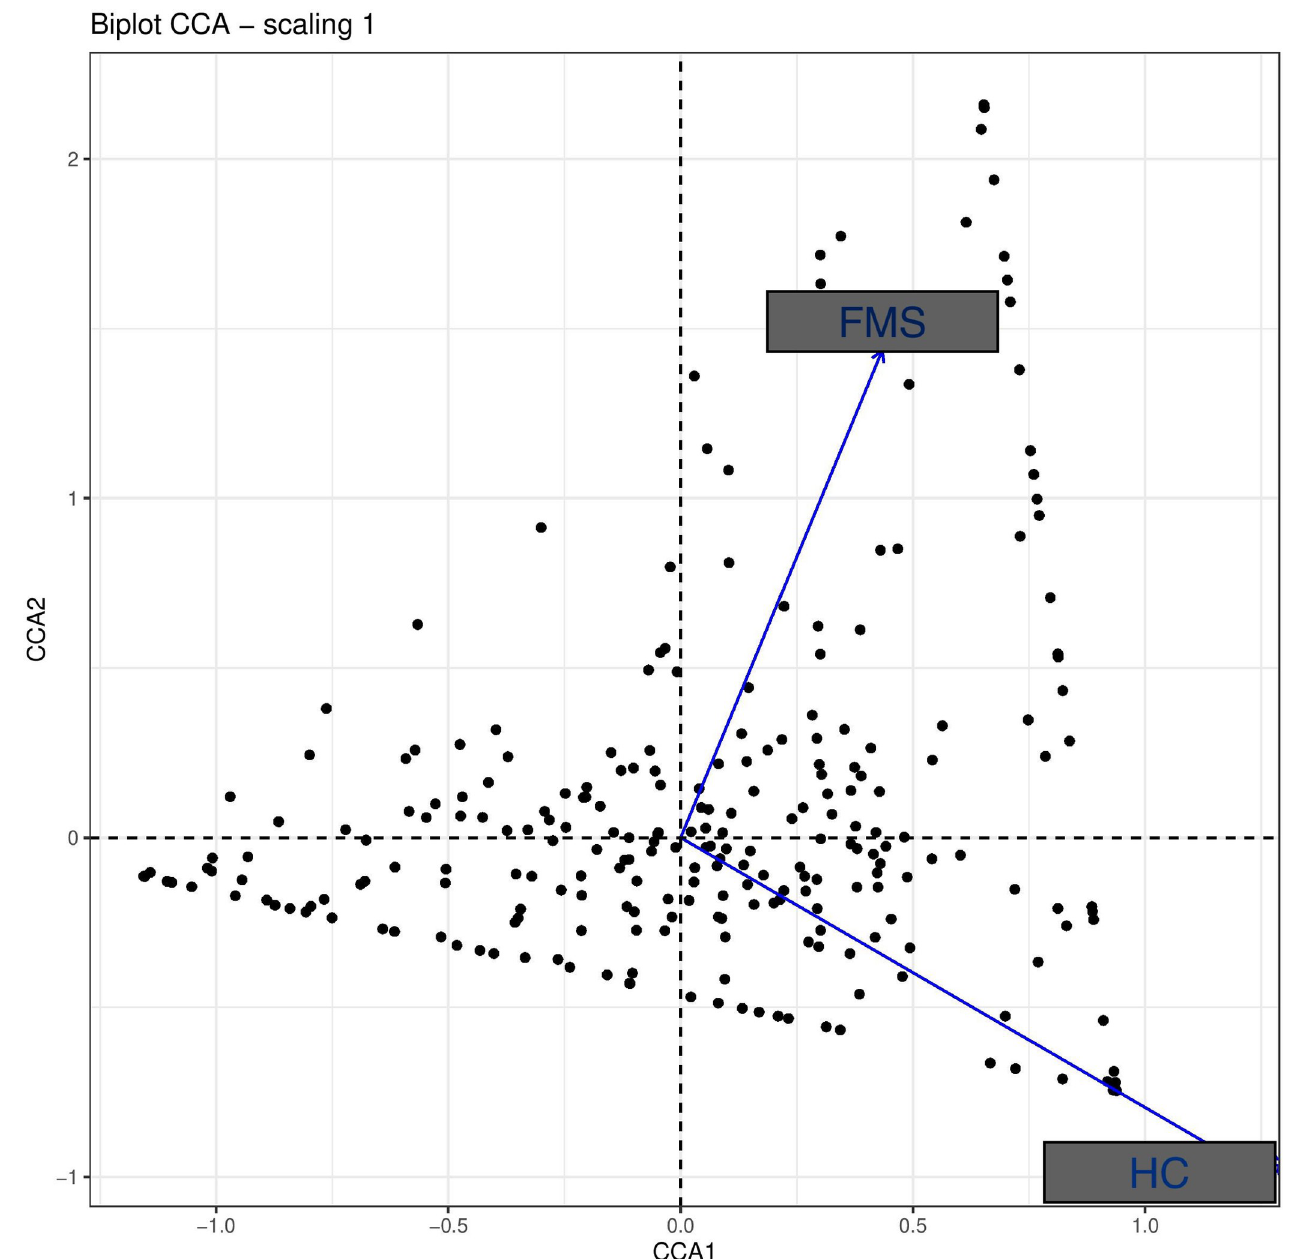
Fig 4. Canonical correspondence analysis (CCA) of the microbiota. CCA analysis of microbiome in FMS patients and healthy controls (HC) failed to reveal a distinct “cluster” to each group.